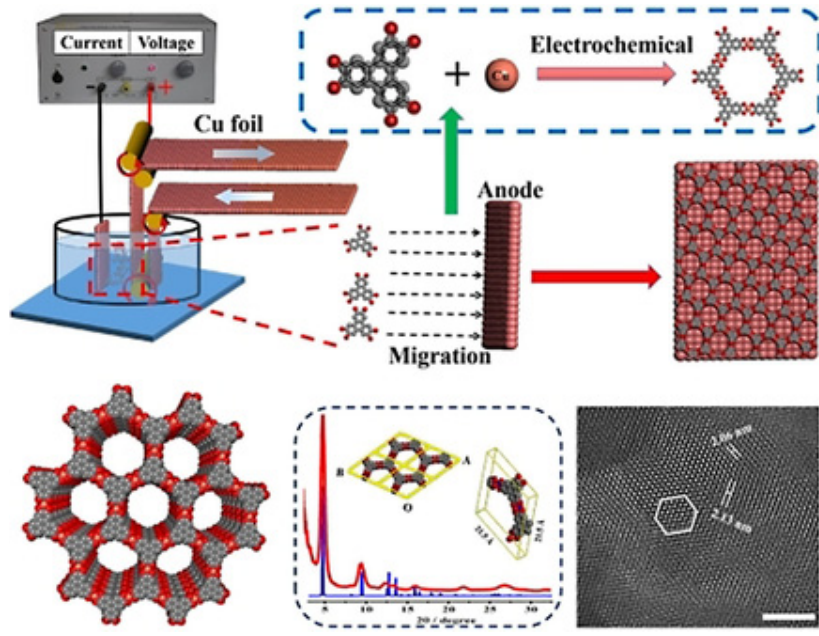
Figure 5. Electrochemical method for MOF synthesis [29]. Reproduced with permission.